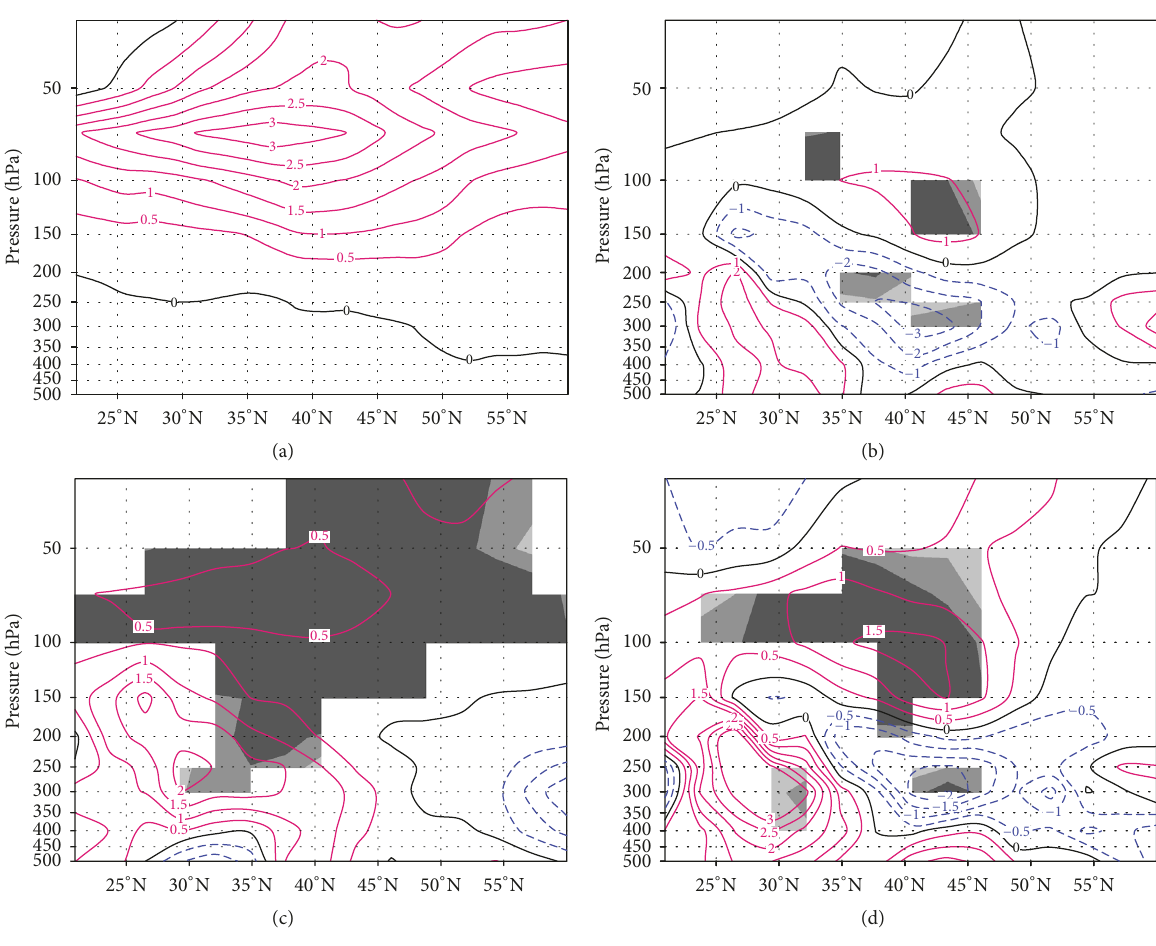
Figure 2: Vertical-latitude cross section of ozone ((a), units: 10 −7 mol/mol), longwave heating rate ((b), units: 10 −6 K/s), shortwave heating rate ((c), units: 10 −6 K/s), and net radiative heating rate ((d), units: 10 −6 K/s) difference between two experiments (SE − CE) along 56 ∘ E in June (shaded values from light to dark exceeding 90%, 95%, and 99% confidence level,